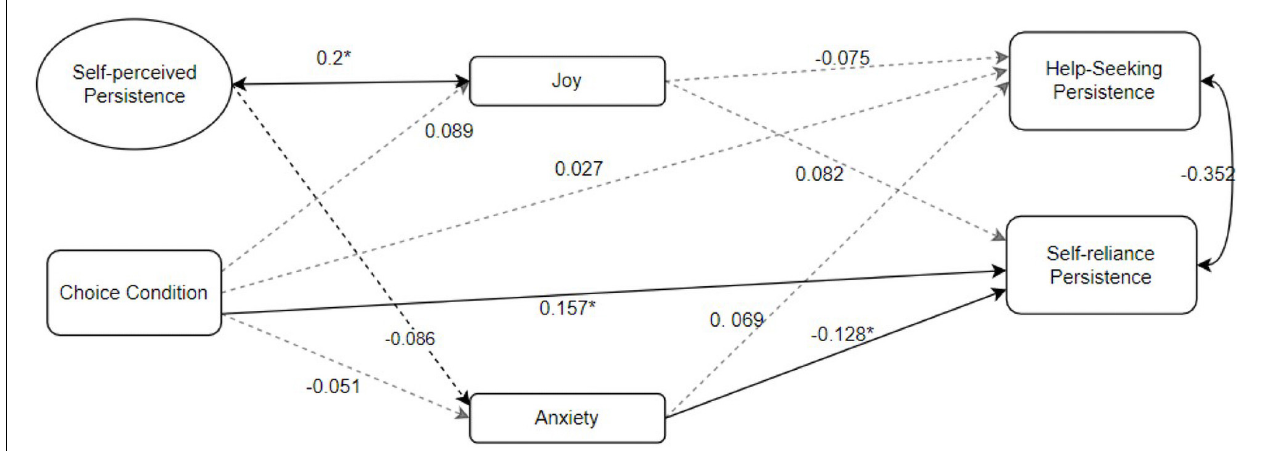
FIGURE 3 | Structural equational modeling results. * p < 0.05. Omitted controlling factors include: gender (help-seeking persistence*: β = 0.107, p = 0.049; self-reliance persistence: β = –0.103, p = 0.055; anxiety: β = 0.003, p = 0.968; joy: β = –0.071, p = 0.339); trait of anxiety (help-seeking persistence: β = –0.026, p = 0.668; self-reliance persistence: β = –0.073, p = 0.356; anxiety: β = 0.079, p = 0.353; joy: β = –0.030, p = 0.722); sum scores (help-seeking persistence*: β = –0.122, p = 0.025; self-reliance persistence*: β = 0.349, p < 0.001); Response Time (help-seeking persistence*: β = 0.693, p < 0.001; self-reliance persistence: β = 0.069, p =